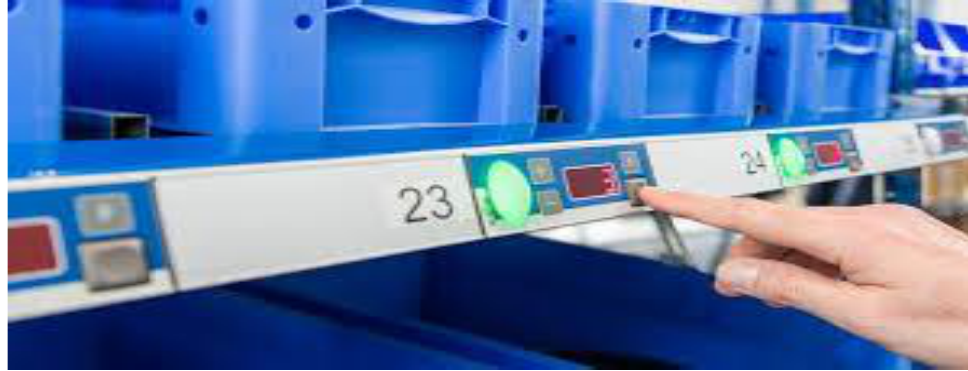
Figure 3. Order picking by light detection [33].